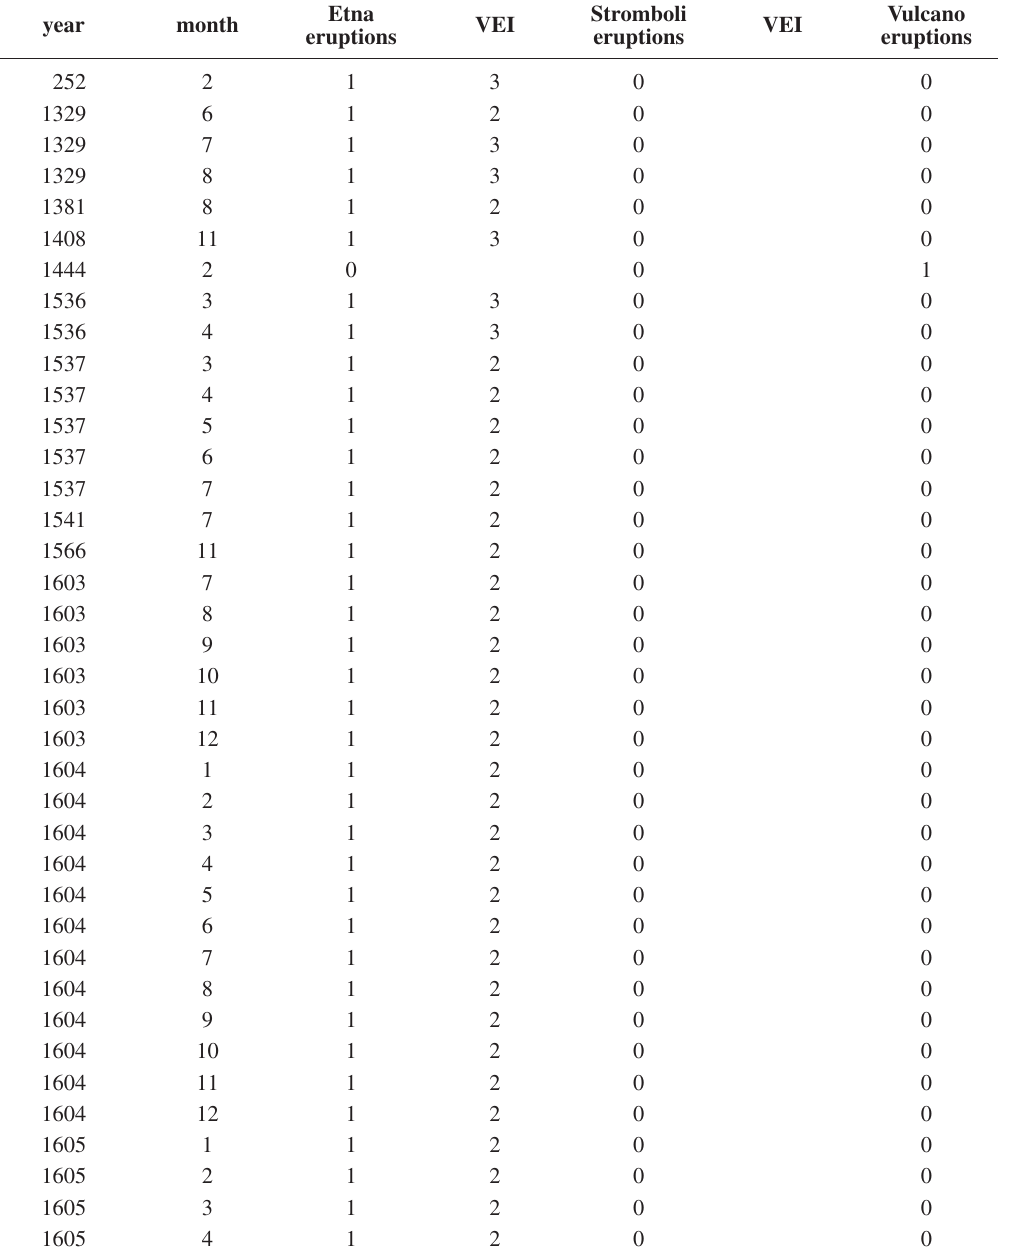
Table III. Eruption (with VEI ≥ 2) occurrences by month between 0 and 1993 AD at Etna, Stromboli, and Vul- cano. VEI = Volcanic Explosivity Index; 0 = no occurrence; 1 = occurrence. Data are from Simkin and Siebert